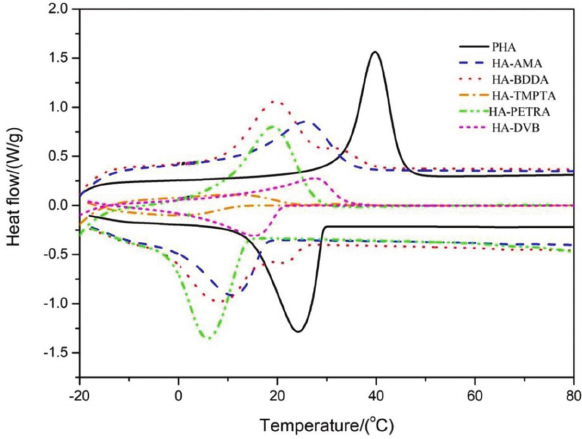
Figure 5: DSC curve of microspheres with various cross-linking Table 1: Thermal properties of microspheres with various cross- linking agents. Material